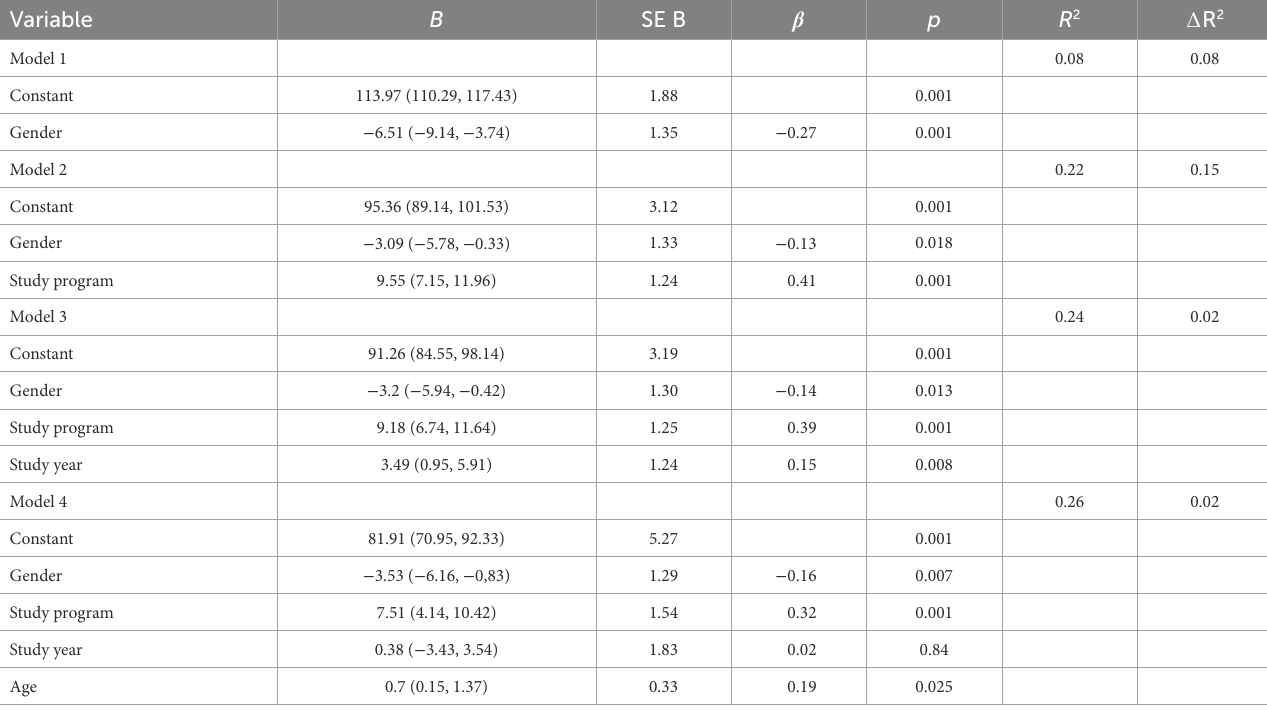
TABLE 2 Summary of regression analysis for variables predicting MentS-total.